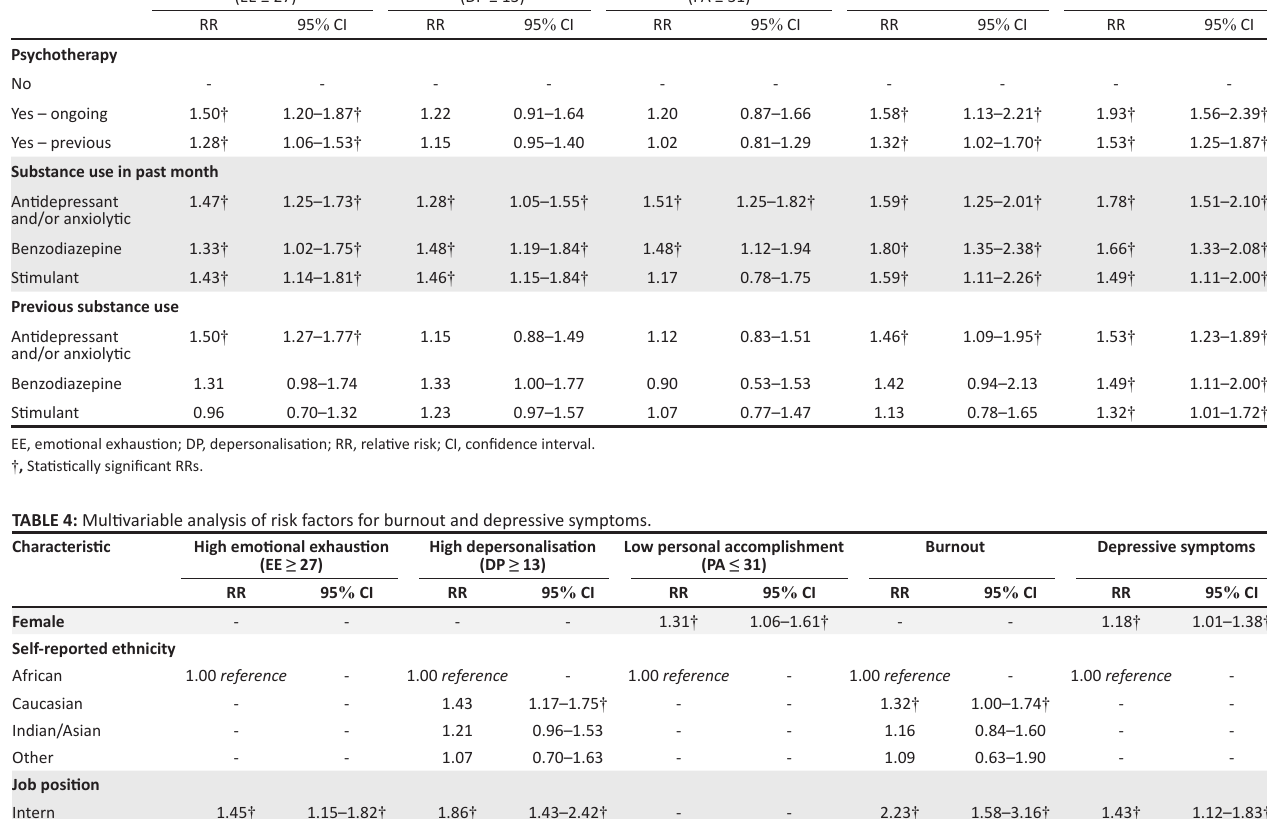
Self-reported ethnicity African